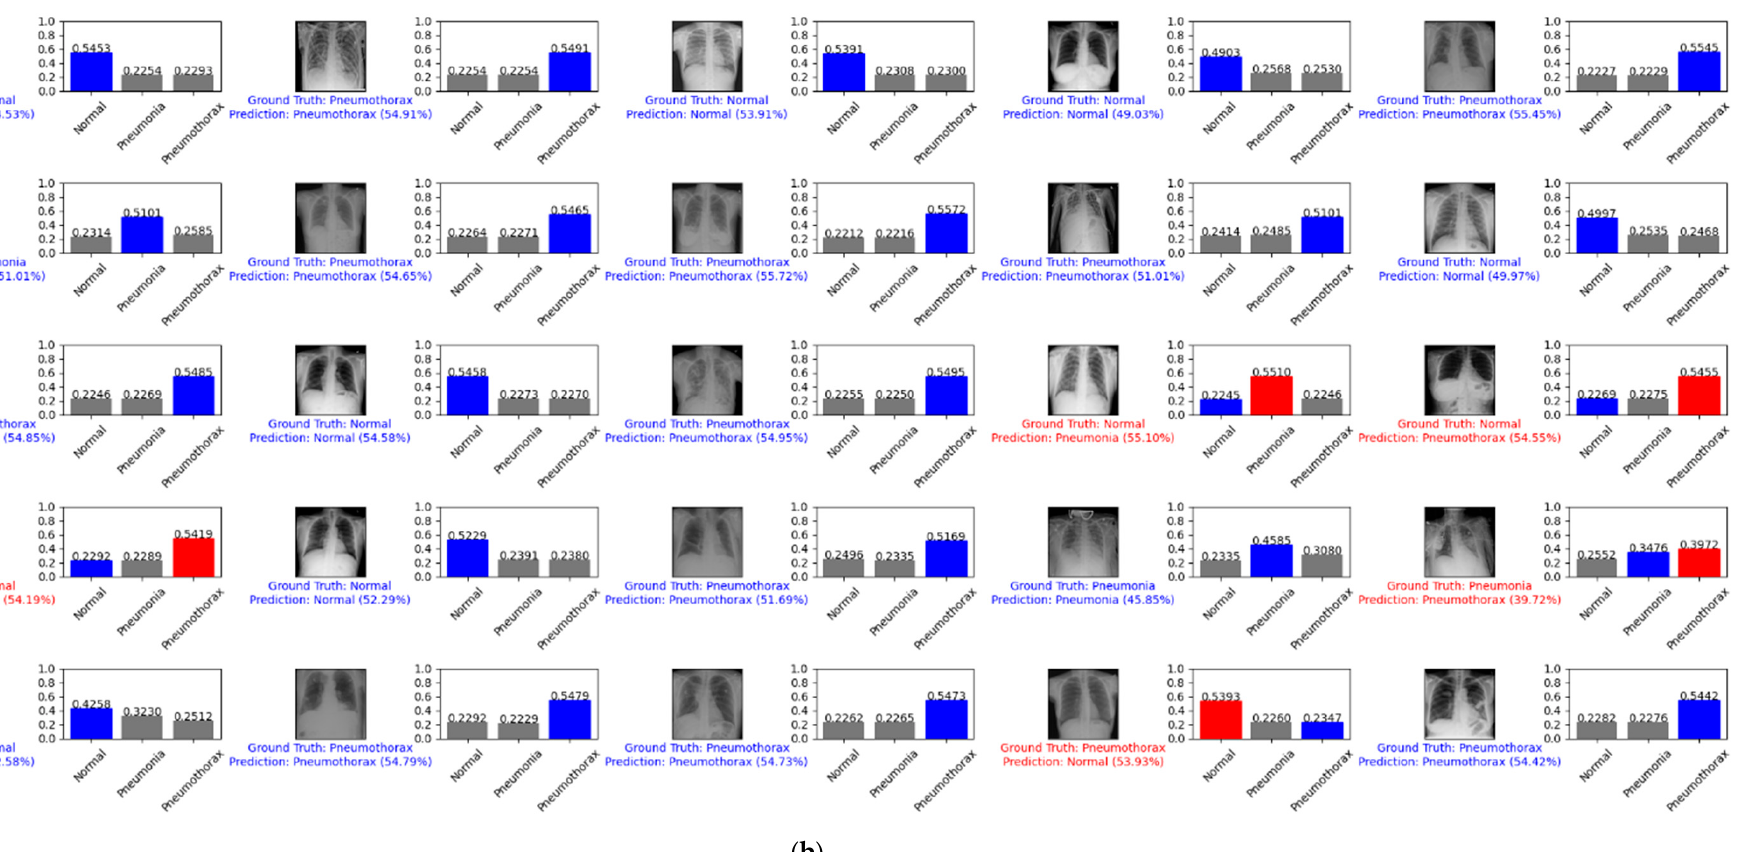
Figure 9. Example predictions on the normal, pneumonia, and pneumothorax classes of the validation set of the NIH data set: ( a ) the first 25 images of the normal class; ( b ) 25 random images.